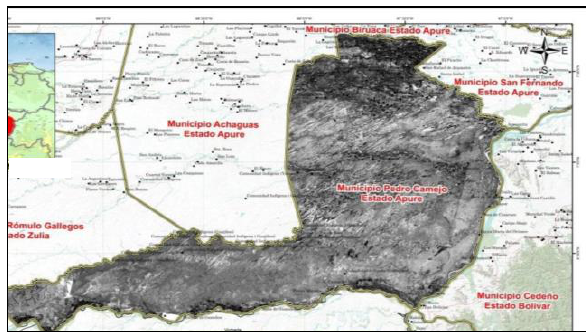
Figure 3. Image fraction of the water